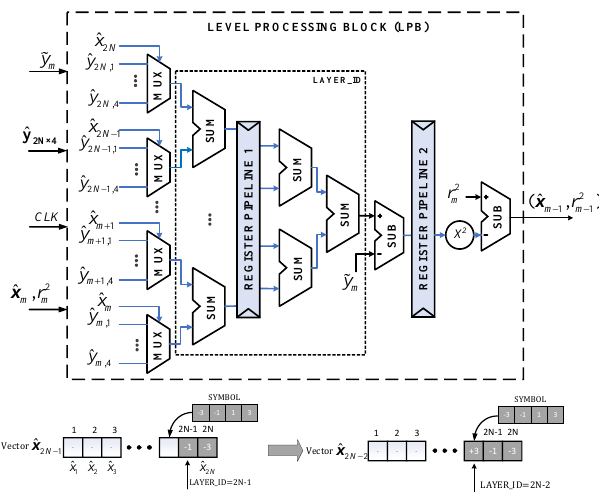
Figure 9. Detailed hardware implementation of a